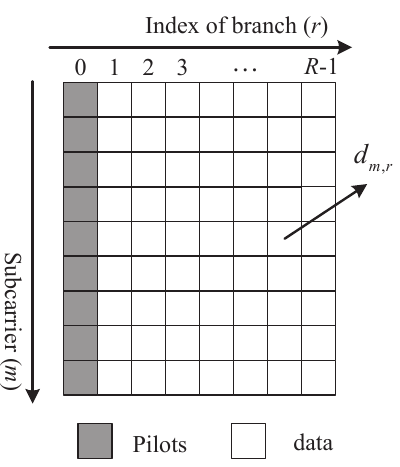
Figure 7. Pilot design in the proposed